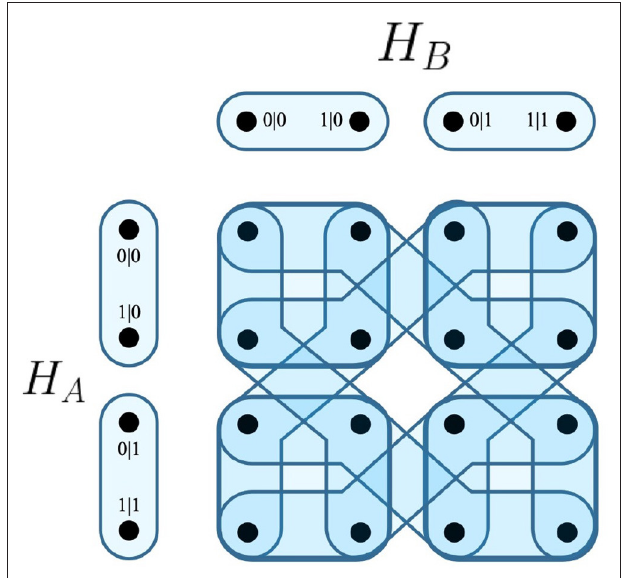
FIGURE 3 | F-R product of contextuality scenarios H A and H B